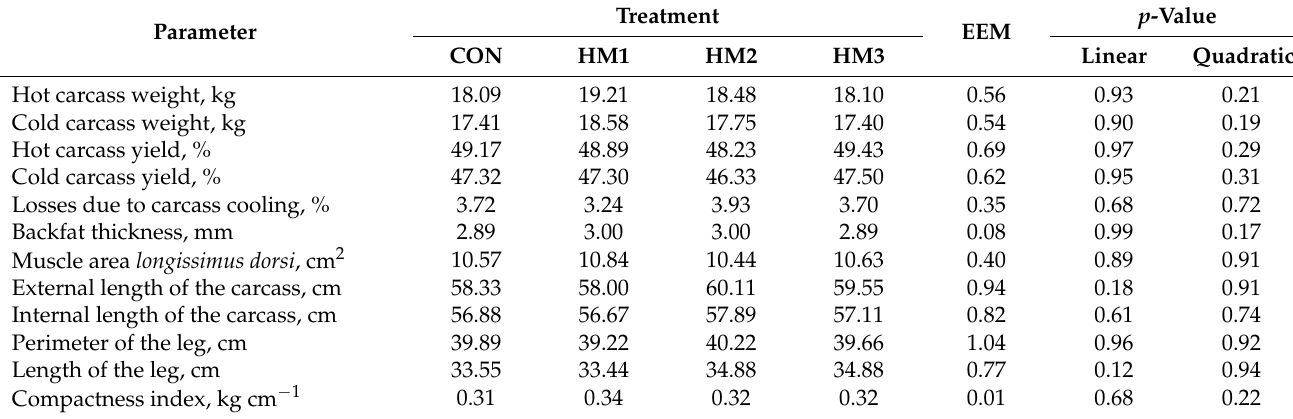
Table 2. Carcass characteristics of lambs supplemented with a polyherbal mixture 1 during the final fattening period. Parameter